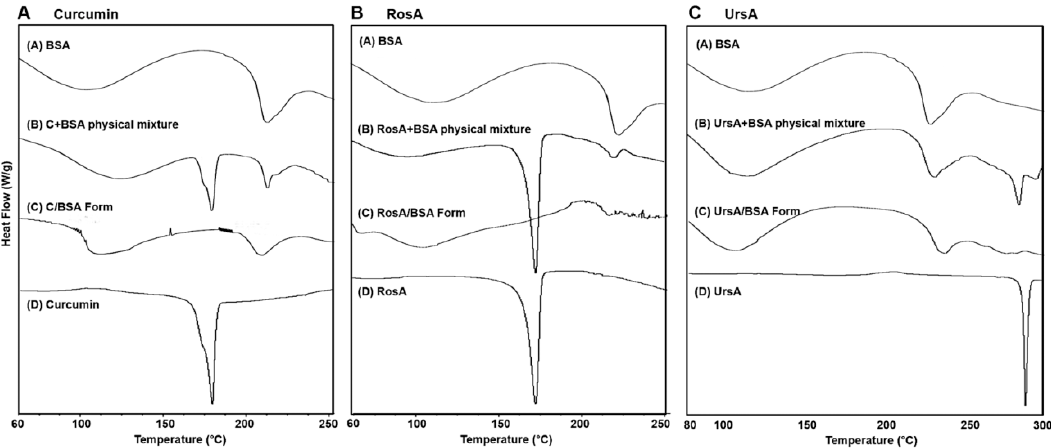
Figure 2. Differential scanning calorimetry (DSC) data of BSA-based formulations with pure drug compounds and physical mixtures of drug and BSA. The results show the DSC peak patterns including ( A ) curcumin (C), ( B ) rosmarinic acid (RosA), and ( C ) ursolic acid (UrsA).